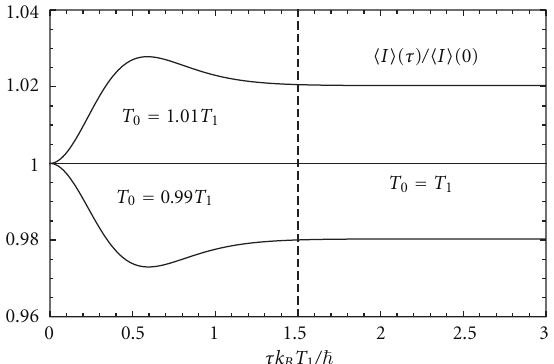
Figure 5: The same as in Figure 4 but with thermal light in both ports with T 1 = 1 . 01 T 0 (upper curve), T 1 = 0 . 99 T 0 (lower curve), and T 1 = T 0 (solid line). The vertical dashed line corresponds to the thermal coherence length l c = cτ c with τ c k B T 1 / (cid:2) (cid:13) 1 . 5.